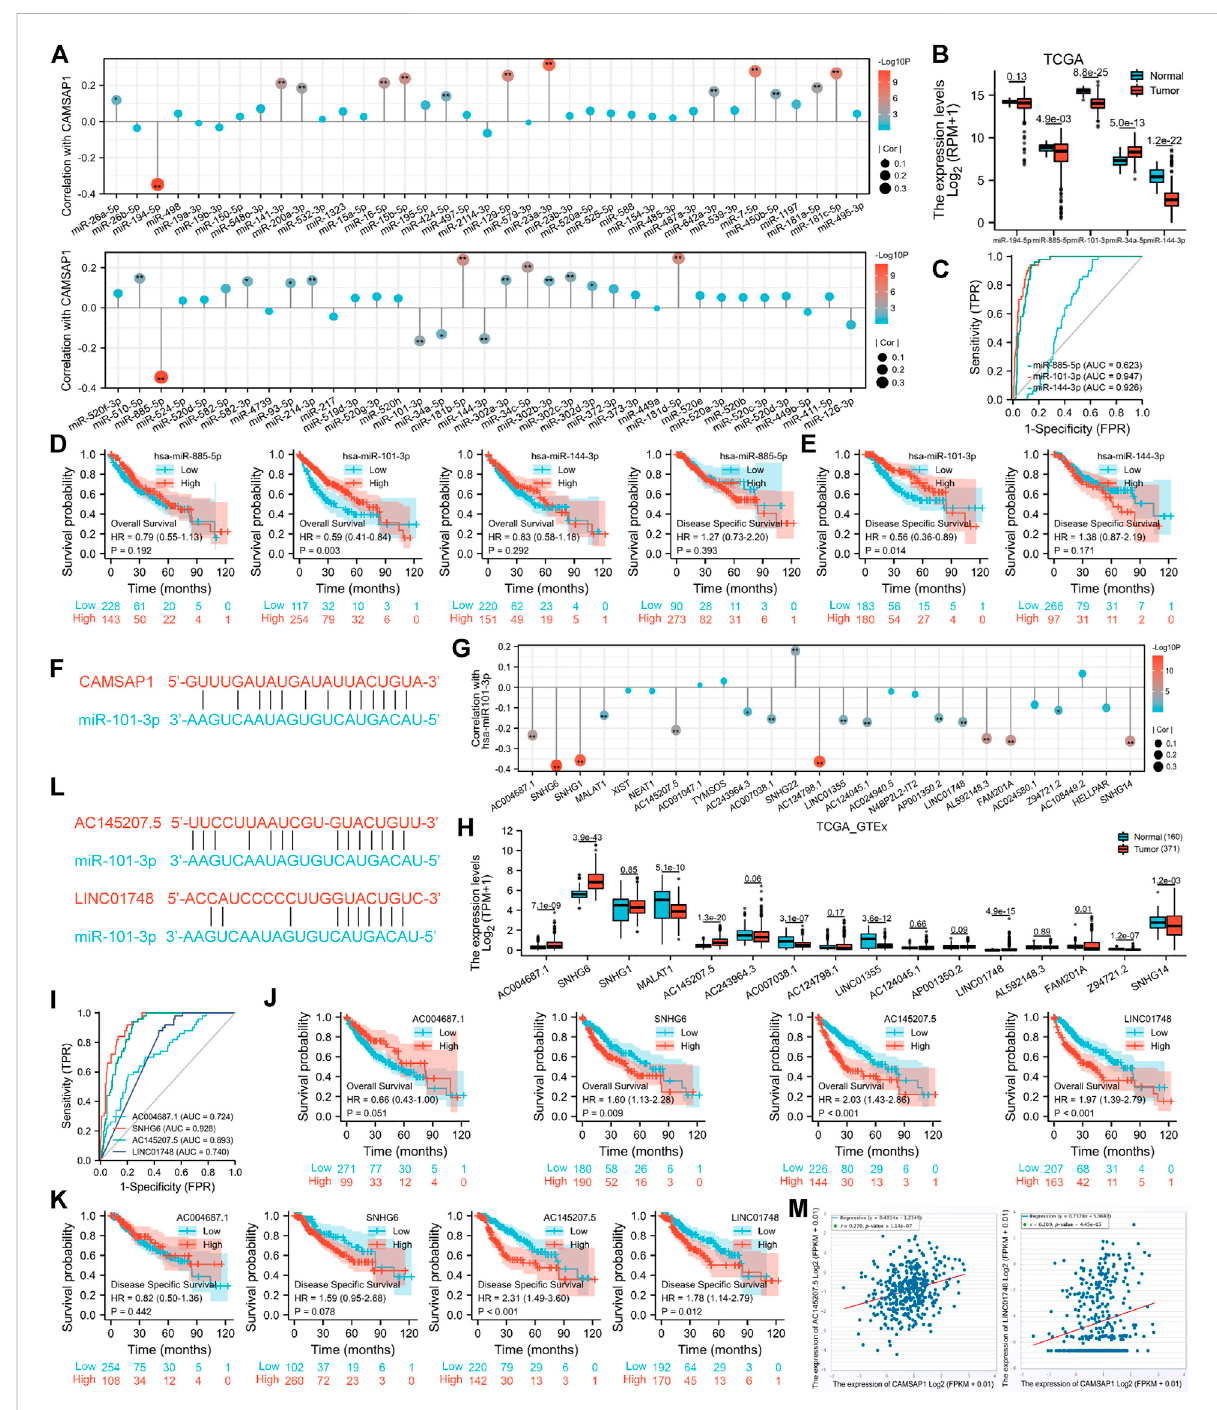
FIGURE 5 TheAC145207.5/LINC01748-miR-101 – 3paxisisspeci fi callyresponsiblefor CAMSAP1 overexpressioninLIHC. (A,G) Lollipopplotsofspearman correlation between CAMSAP1 and predicted miRNAs (A) , miR-101 – 3p, and predicted lncRNAs (G) from ENCORI portal. * p < 0.05, ** p < 0.01. (B,H) The expression of negatively correlated miRNAs of CAMSAP1 (B) and negatively correlated lncRNAs of miR-101 – 3p (H) in normal and LIHC tissues from TCGA and TCGA plus GTEx database. * p < 0.05, ** p < 0.01, *** p < 0.001. (C,I) ROC analyses of negatively correlated miRNAs (C) and lncRNAs (H) . (D,E,J,K) KManalyses forOSandDSSofnegativelycorrelated miRNAs (D,E) andlncRNAs (J,K) . (F,L) Thepairing sequenceof CAMSAP1